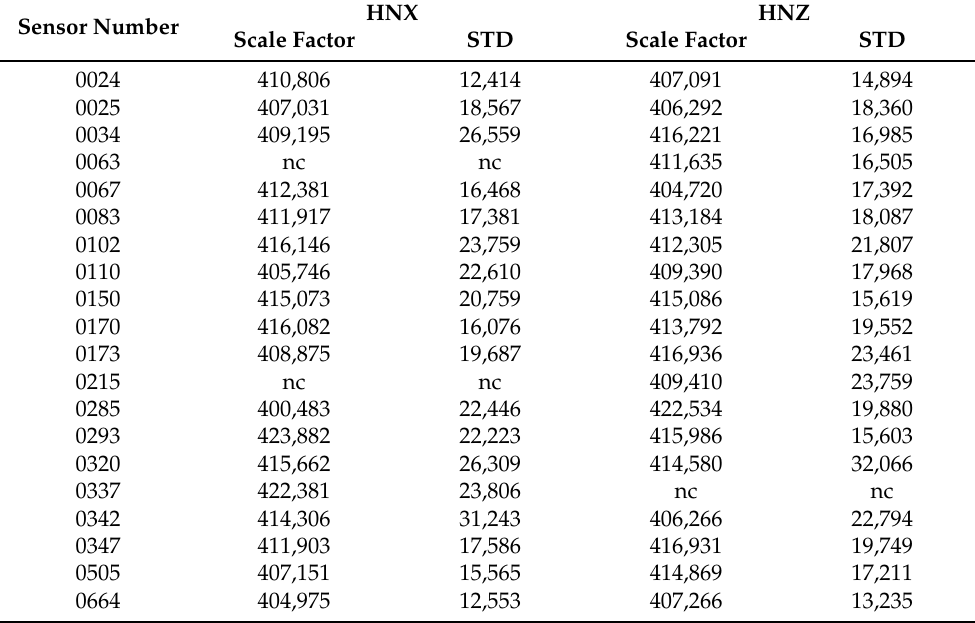
Table 4. The scale factors and standard deviations of the scale factors for each accelerometer. ‘nc’ denotes “not connected” indicating that these components were not operational. All have units of countss 2 m − 1